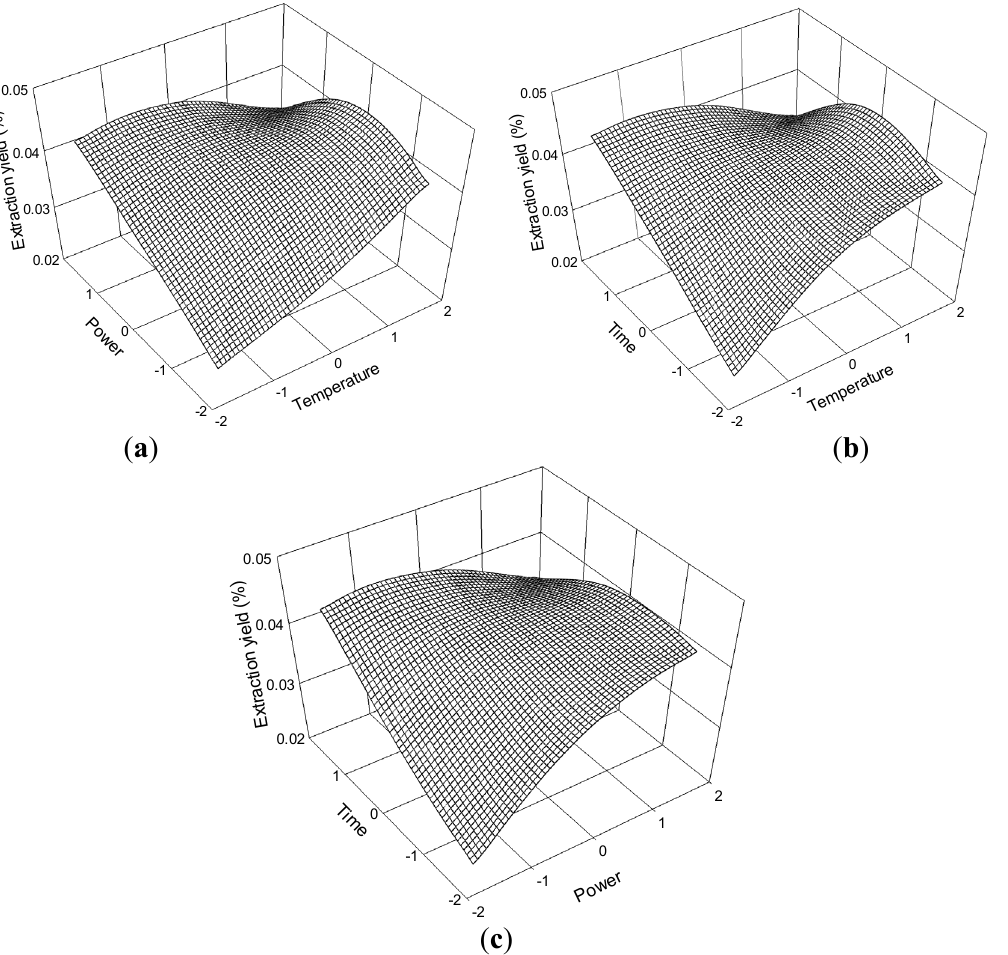
Figure 13. Response surface plots for the effects of ( a ) temperature/power ( b ) temperature/time ( c ) power/time on the extraction yield of levistolide